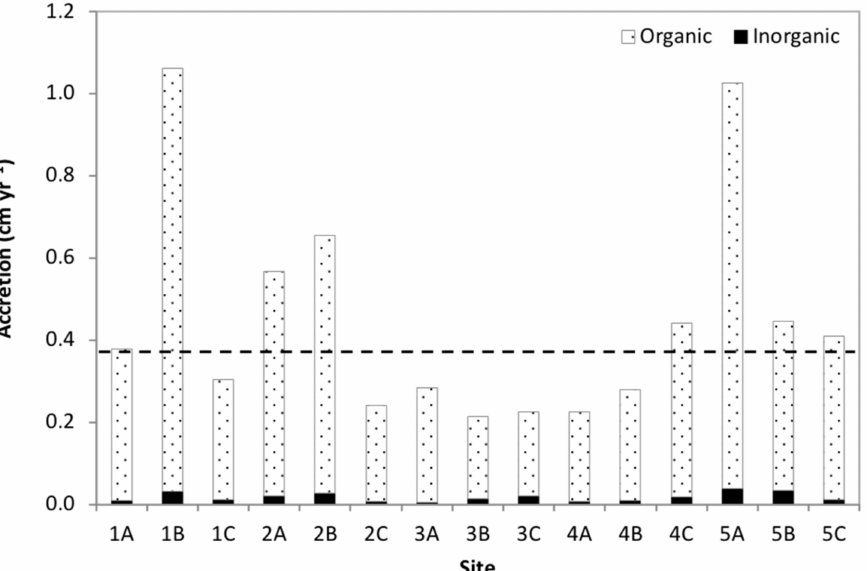
Figure 7. Vertical accretion rates (cm yr − 1 ) along the Nanticoke River with contributions from organic (including water/porespace) and inorganic inputs. Dotted line indicates RLSR for Cambridge, Maryland (0.377 cm yr − 1 ) from 1943 to 2018 obtained from http://www.tidesandcurrents.noaa.gov/, accessed on 13 May